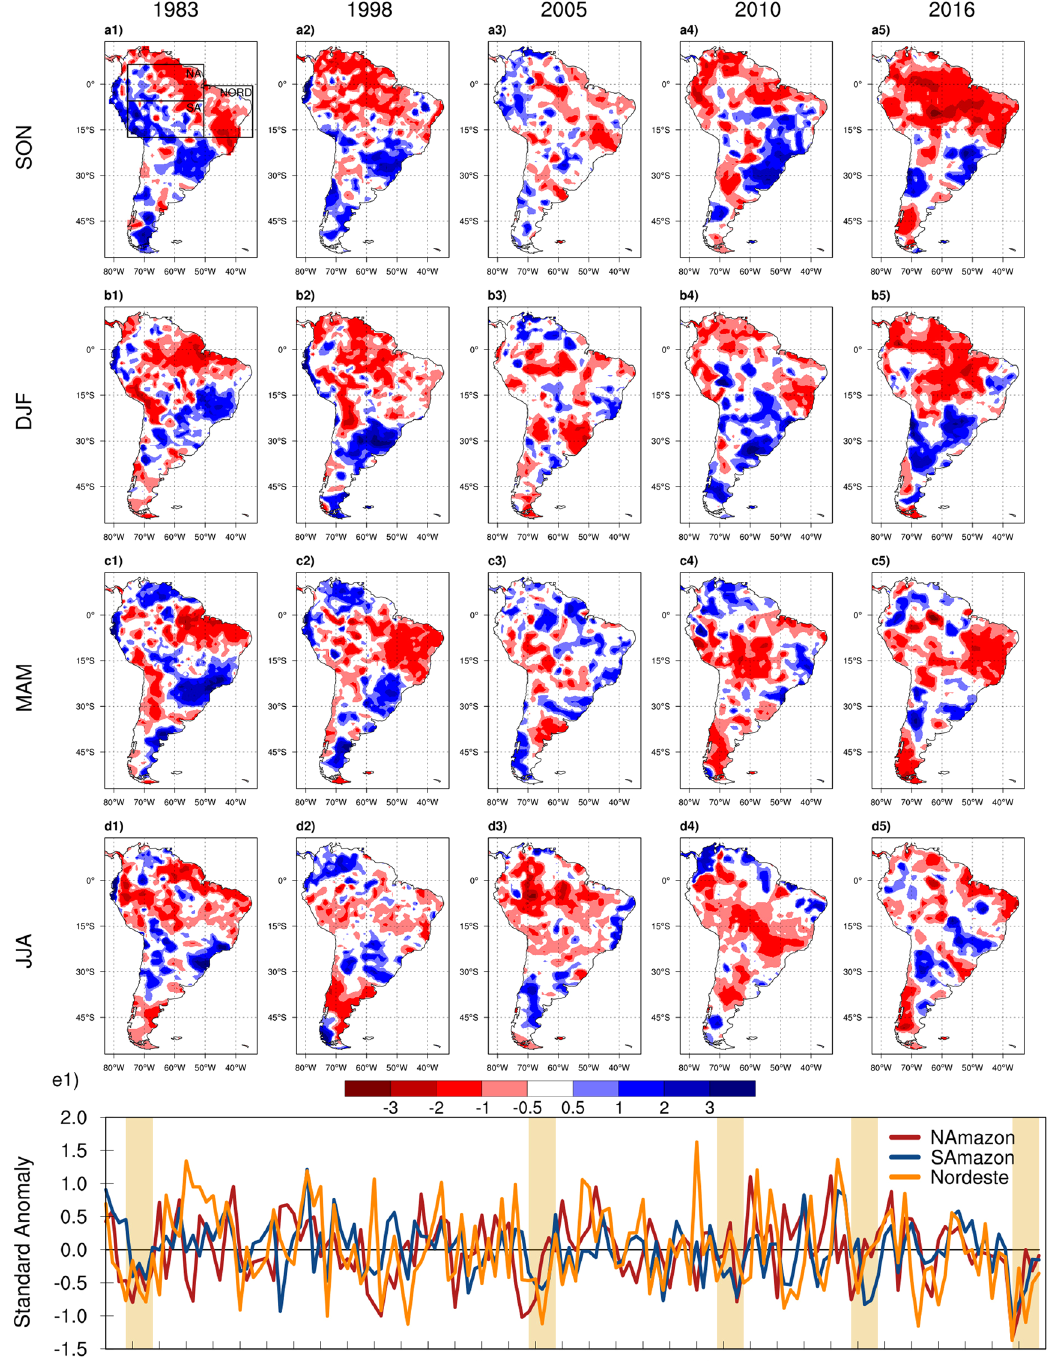
Figure 2. Spatial maps and time series of standardized precipitation anomalies (dimensionless) calculated for the 1982–2017 period. The contour plots present the seasonal rainfall anomalies for the five extreme droughts of 1983 ( a1 to d1 ), 1998 ( a2 to d2 ), 2005 ( a3 to d3 ), 2010 ( a4 to d4 ), and 2016 ( a5 to d5 ). The monthly time series ( e1 ) were constructed by averaging the 3-month SPI over the North Amazon, South Amazon, and Nordeste regions (the box shown in a1 ) and the highlight strips denote the five extreme droughts represented in the spatial maps. Seasonal cycles for each year start from September of the previous year (e.g. SON 2004 for 2005 seasonal cycle). Figures created with: The NCAR Command Language (Version 6.3.0) [Software]. (2016). Boulder, Colorado: UCAR/NCAR/CISL/TDD.